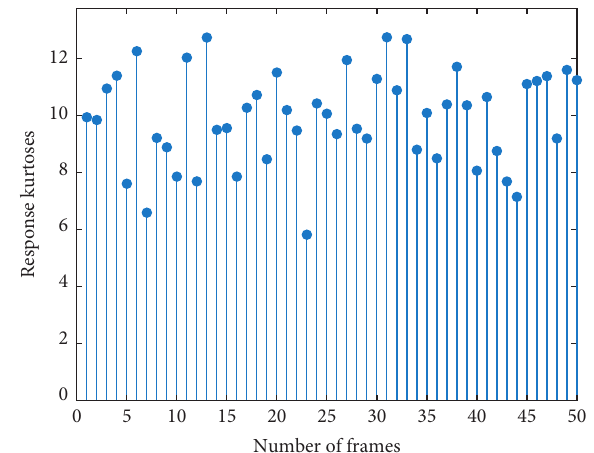
Figure 18: Kurtoses of all 50 blocks of the super-Gaussian response.